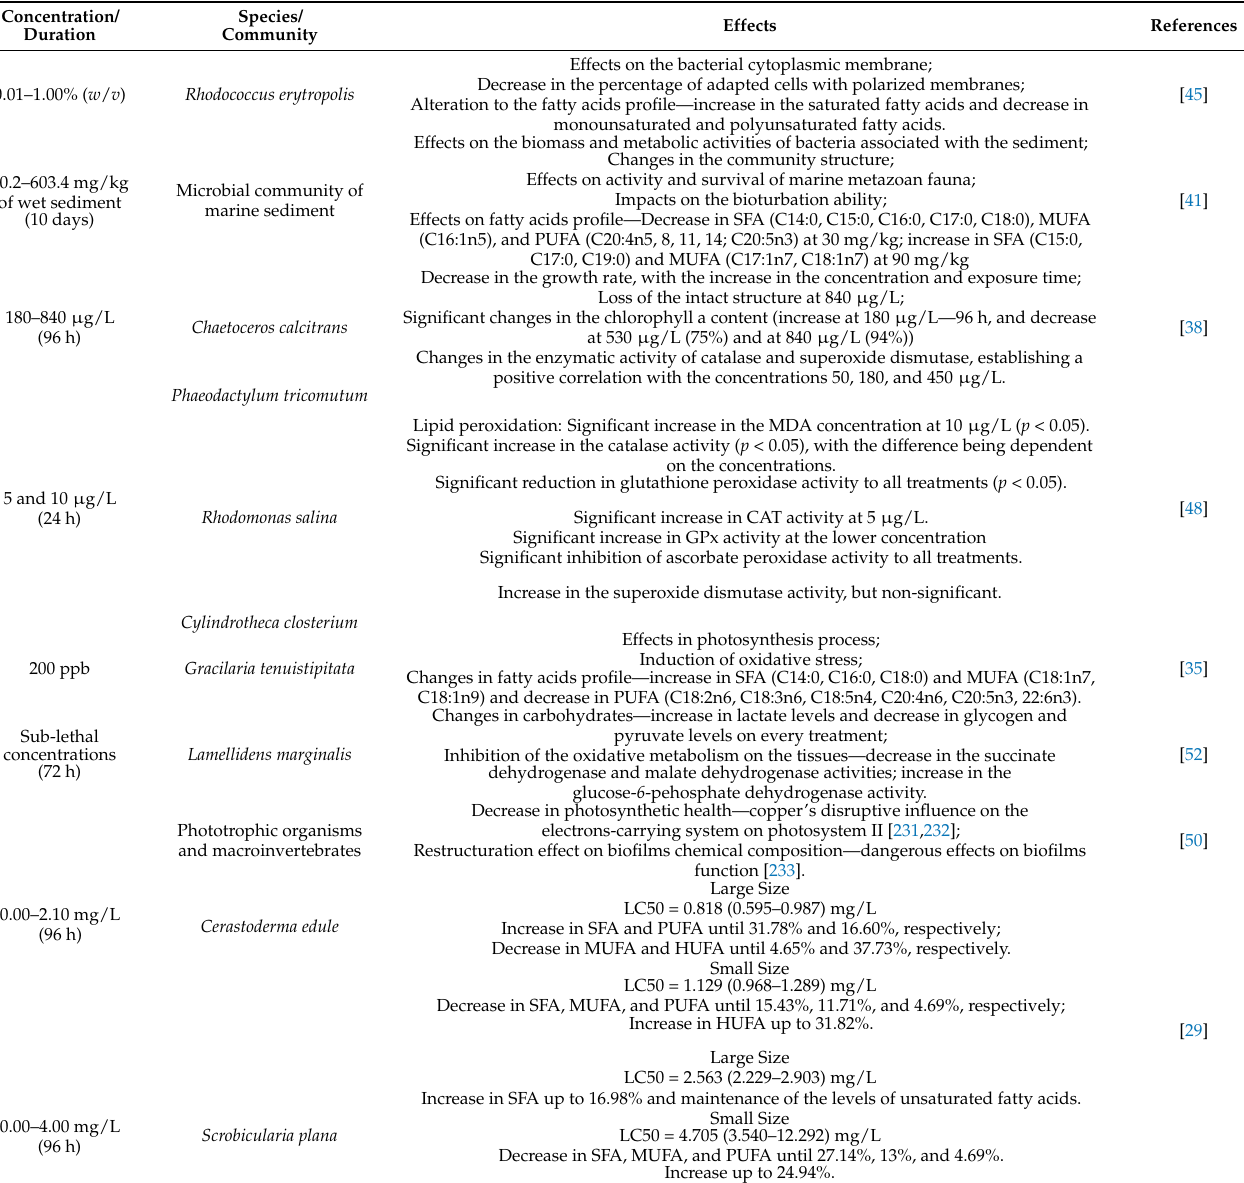
Table 3. Effects of copper under the form of copper sulphate on several species, to evaluate different parameters, such as lethality, behavior, or biochemical